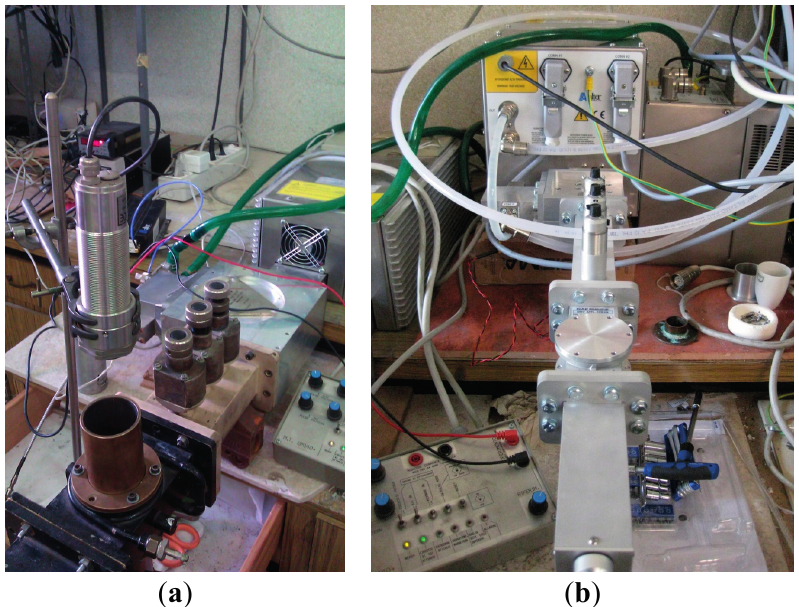
Figure 1. ( a ) Single-mode applicator, 2450 MHz, with measuring port and optical pyrometer on top; ( b ) single-mode applicator, 5800 MHz, with measuring port temporarily